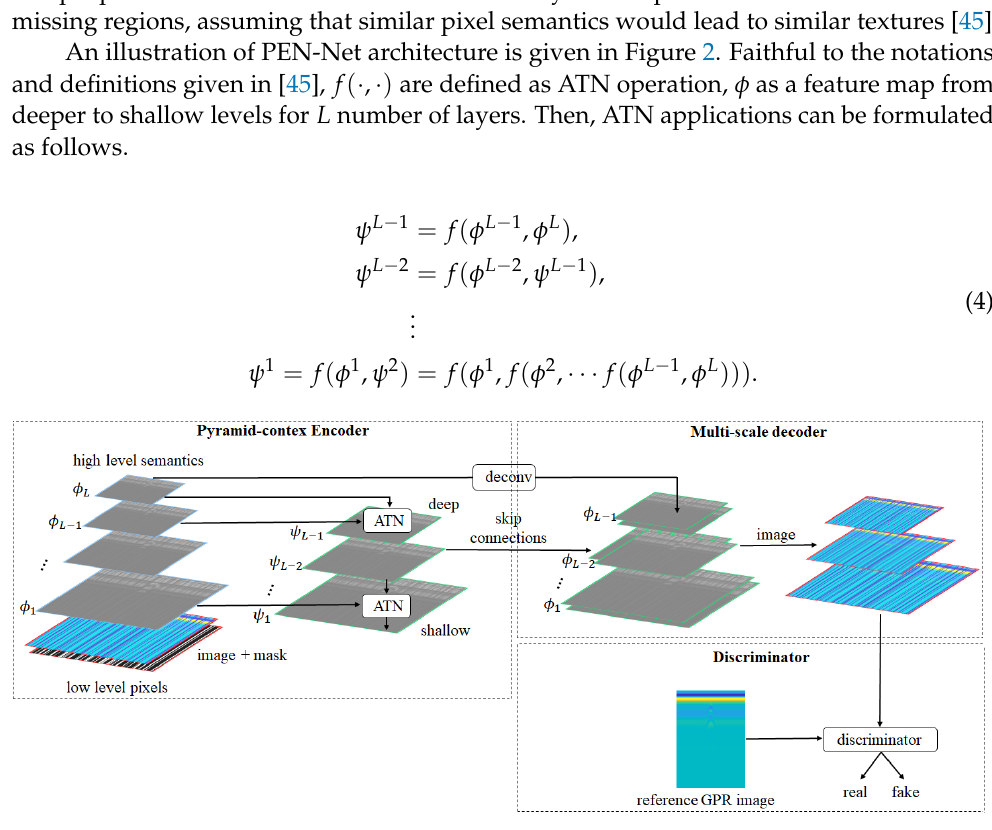
Figure 2. Block diagram of the PEN-Net